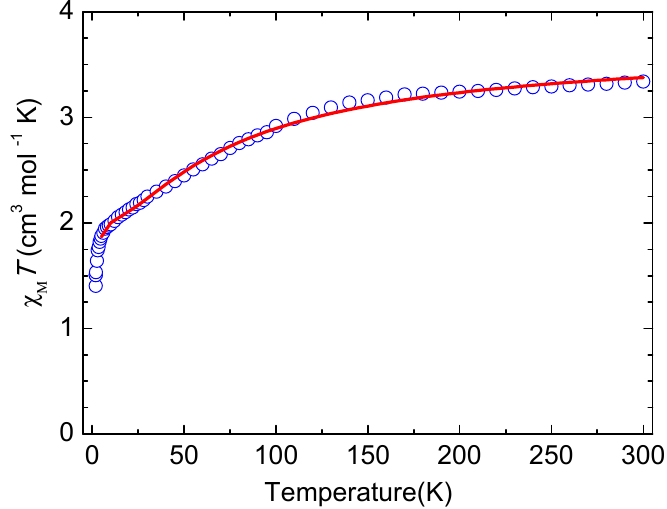
Figure 6. Plot of χ M T vs. T of compound 1 in an applied field of 1 kOe from 2 to 300 K. The solid line represents the best fit.